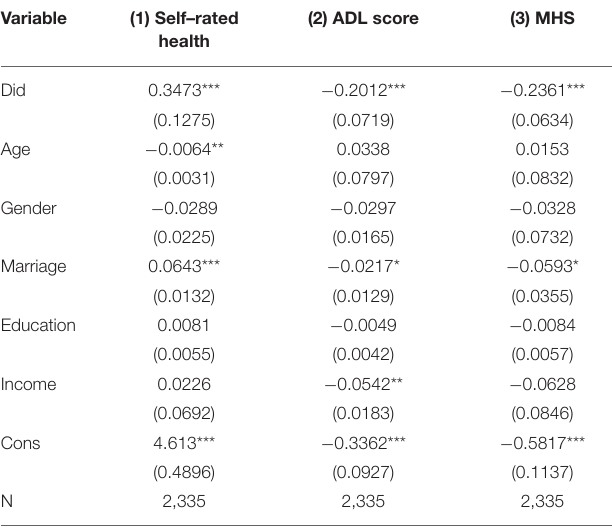
TABLE 9 | DID results with the second trial tier 11 cities as the control group.